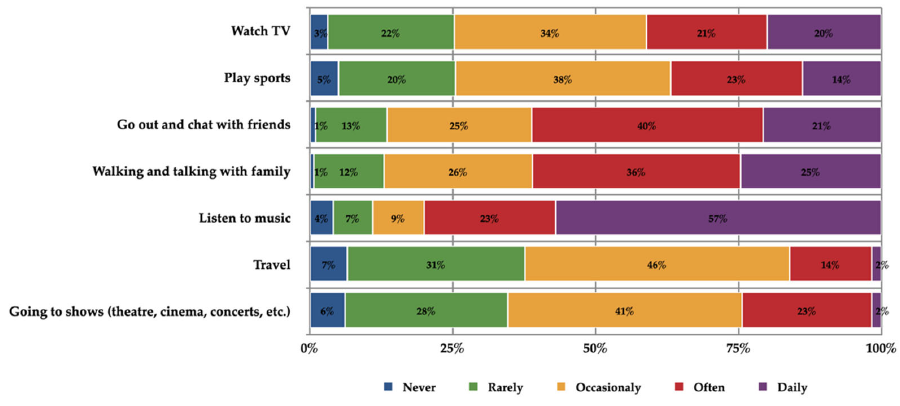
Figure 3. Frequency of performing activities offline.